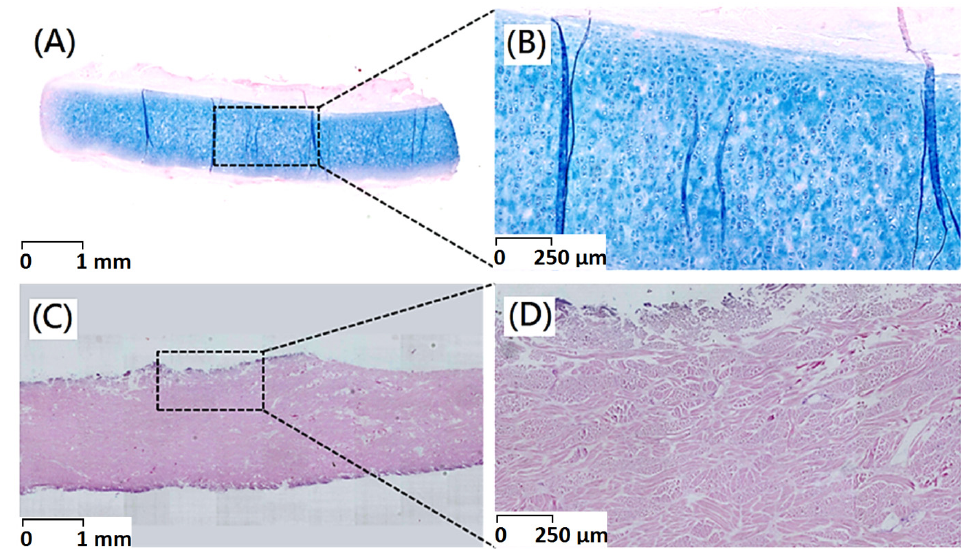
Figure 3. Alcian blue staining of ( A ) original porcine dermal (scale bar indicates 1 mm) ( B ) original porcine dermal (scale bar indicates 250 μ m) ( C ) porcine dermal segments after decellularization (scale bar indicates 1 mm) ( D ) porcine dermal segments after decellularization (scale bar indicates 250 μ m).